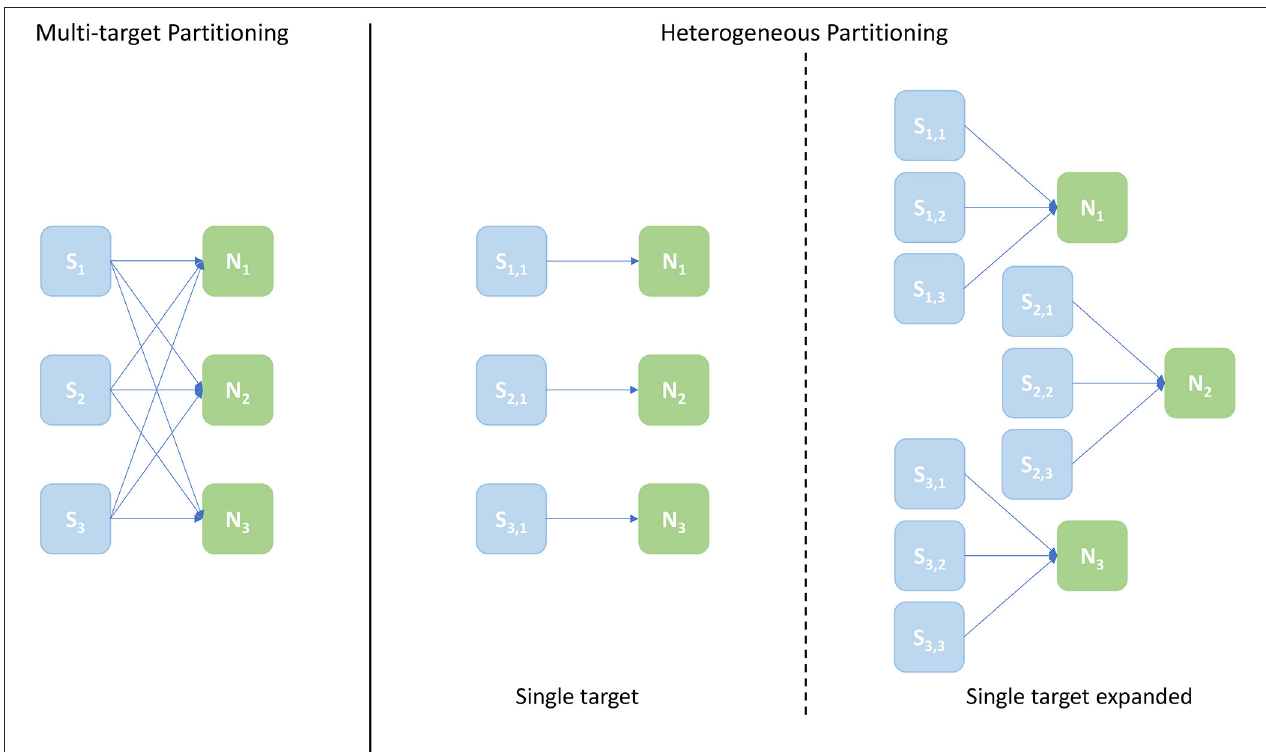
FIGURE 9 | Arrangement of Synapse and Neuron cores under the explored configurations: Multi-target partitioning (left) ; Heterogeneous partitioning (right) . The example shown demonstrates the [3, 3] test case, with 3 Synapse cores and 3 Neuron cores. For the Multi-target partitioning configuration, each Synapse core targets all Neuron cores. Comparison to the Heterogeneous approach is provided by: the Single-target partitioning, where the same overall number of cores are used, but connected one Synapse core to each Neuron core; and the Single-target expanded partitioning, where the same number of Neuron cores is maintained, but each with the same number of Synapse cores as implemented in the Multi-target